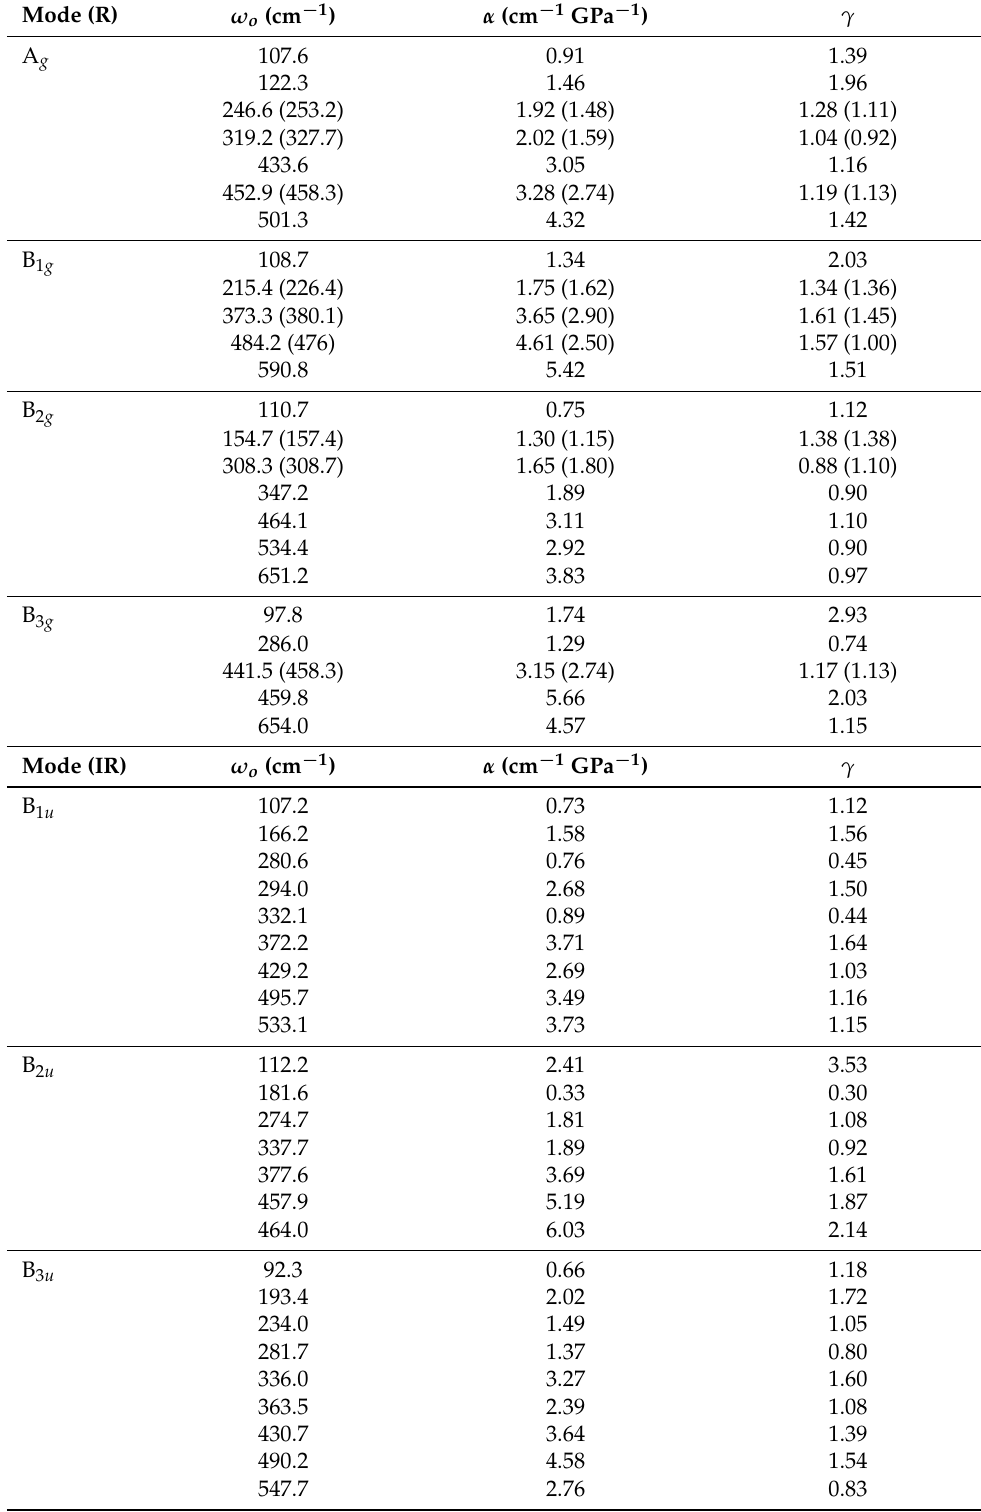
Table 6. Raman (R), infrared (IR), and silent (S) mode frequencies as calculated in this work for DyScO 3 perovskite, and their respective pressure coefficients obtained by fitting in the range up to 15 GPa with a linear equation ω ( p ) = ω o + α p . Mode Grüneisen parameters ( γ ) are also provided using the calculated bulk modulus B o (164.7 GPa). Experimental values from Ref. [11], where available, are given in